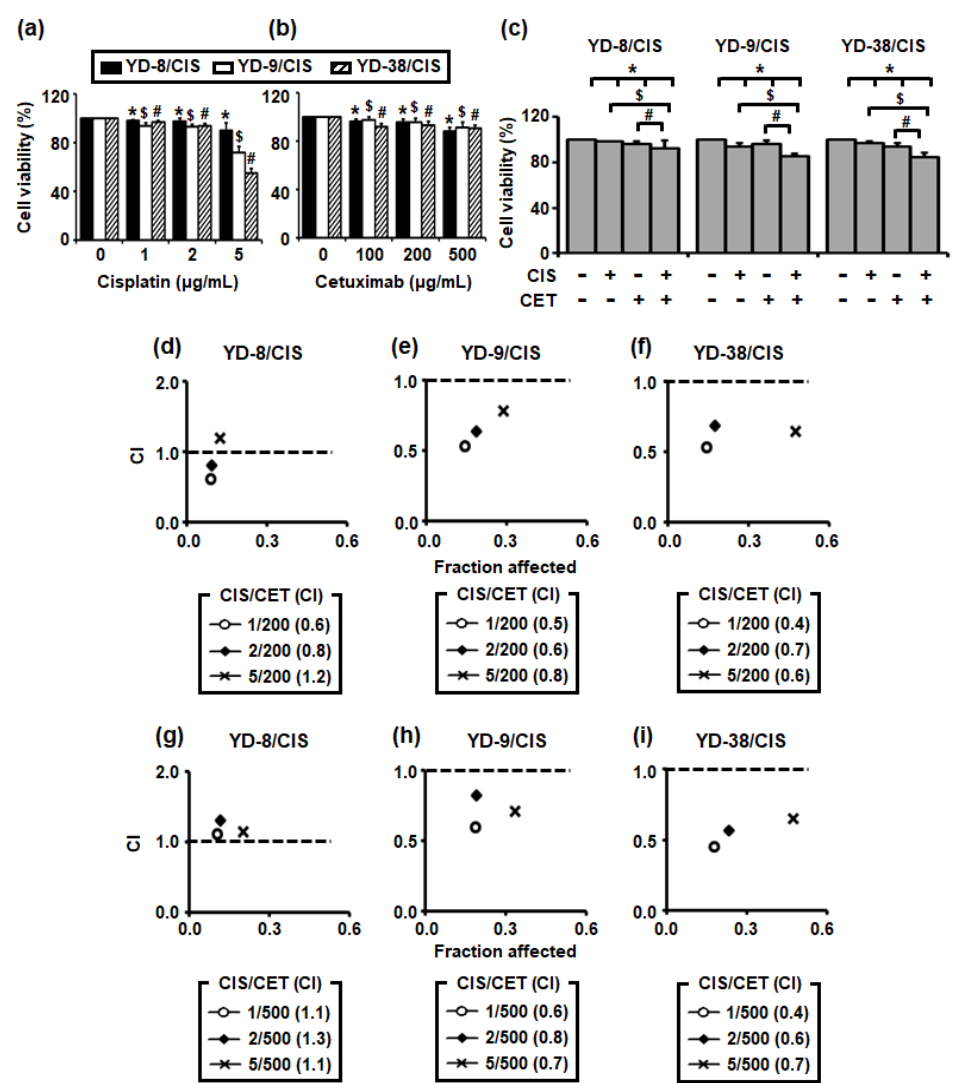
Figure 1. Cisplatin and cetuximab co-treatment had a significant synergistic effect in oral squamous cell carcinoma (OSCC) cancer cell lines. ( a – c ) Cells were treated with cisplatin (CIS) (0–5 μ g/mL) and/or cetuximab (CET) (0–500 μ g/mL) for 72 h. After incubation, combined treatment promoted greater inhibition of cell growth in these cancer cell lines compared to cisplatin (1 µ g/mL) or cetuximab (200 µ g/mL) treatment alone. The effects of cisplatin with or without cetuximab on the viability of YD-8/CIS, YD-9/CIS, and YD-38/CIS cells were determined using the MTT assay (mean ± standard deviation (SD); n = 6). ( a , b ) * p < 0.05 versus non-treated group in YD-8/CIS cells, $ p < 0.05 versus non-treated group in YD-9/CIS cells, and # p < 0.05 versus non-treated group in YD-38/CIS cells. ( c ) * p < 0.05 versus non-treated group, $ p < 0.05 versus only cisplatin-treated group, and # p < 0.05 versus only cetuximab-treated group. ( d – i ) Synergistic effects were noted in most combinations, except for a few cases in YD-8/CIS cells. The fraction affected versus CI plot (CIS/CET) was determined using the Chou–Talalay and CompuSyn software.